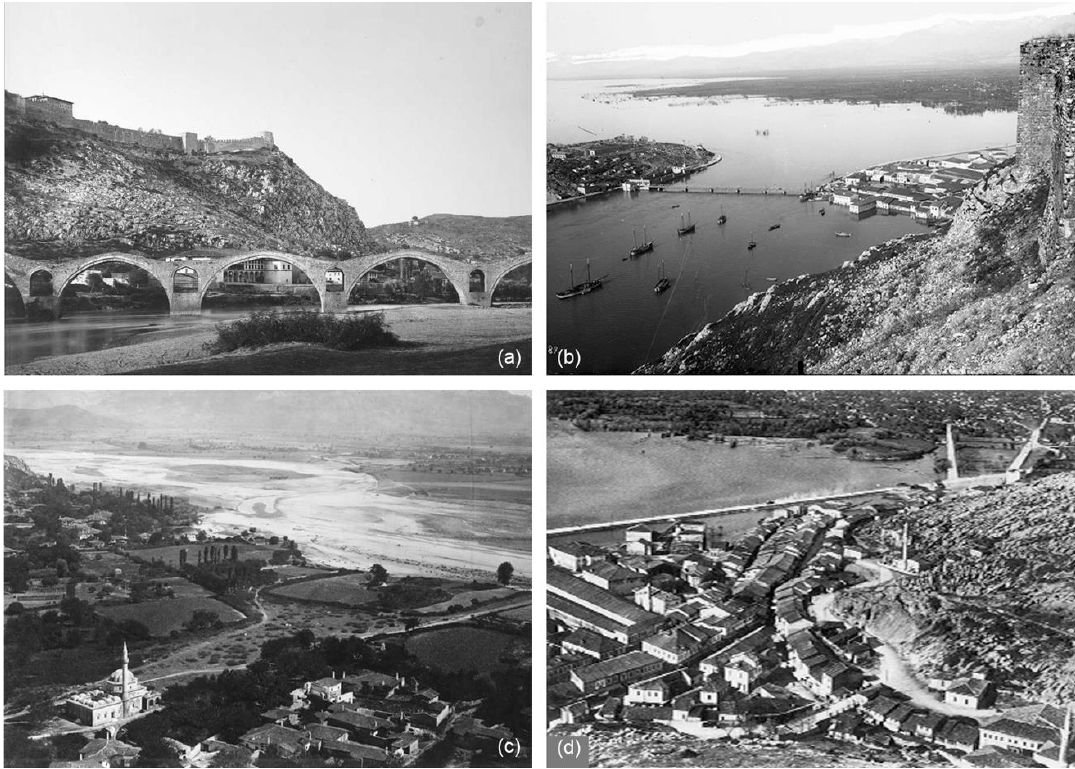
Figure 3 Old quarters of Shkodër in 1863: a) looking northeast, showing bridge on Drinasë/Drin, the citadel with Venetian fortifications, and the remnants of Tabak quarter; b) north from the citadel, showing the Bazaar and the bridge on Bunë; c) southeast from the citadel, showing the erosion by the Drin and the remnants of Tabak quarter; d) looking northwest, Bazaar confined between the riverfront, the marshes, and the